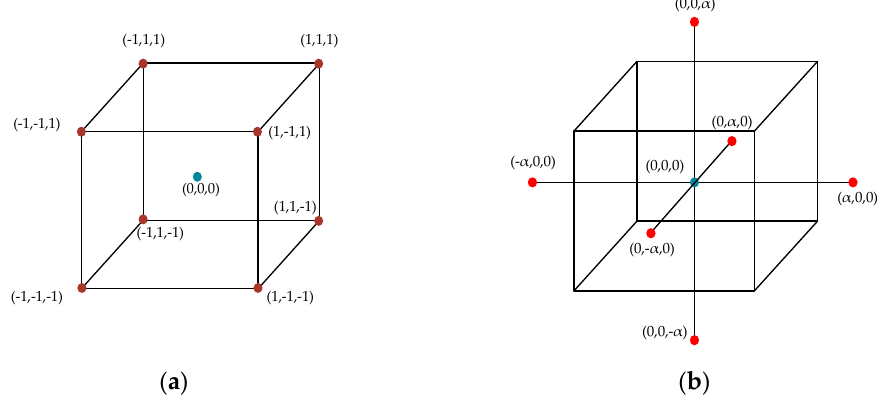
Figure 6. Central Composite Design: ( a ) Cubical point; ( b ) axial point.